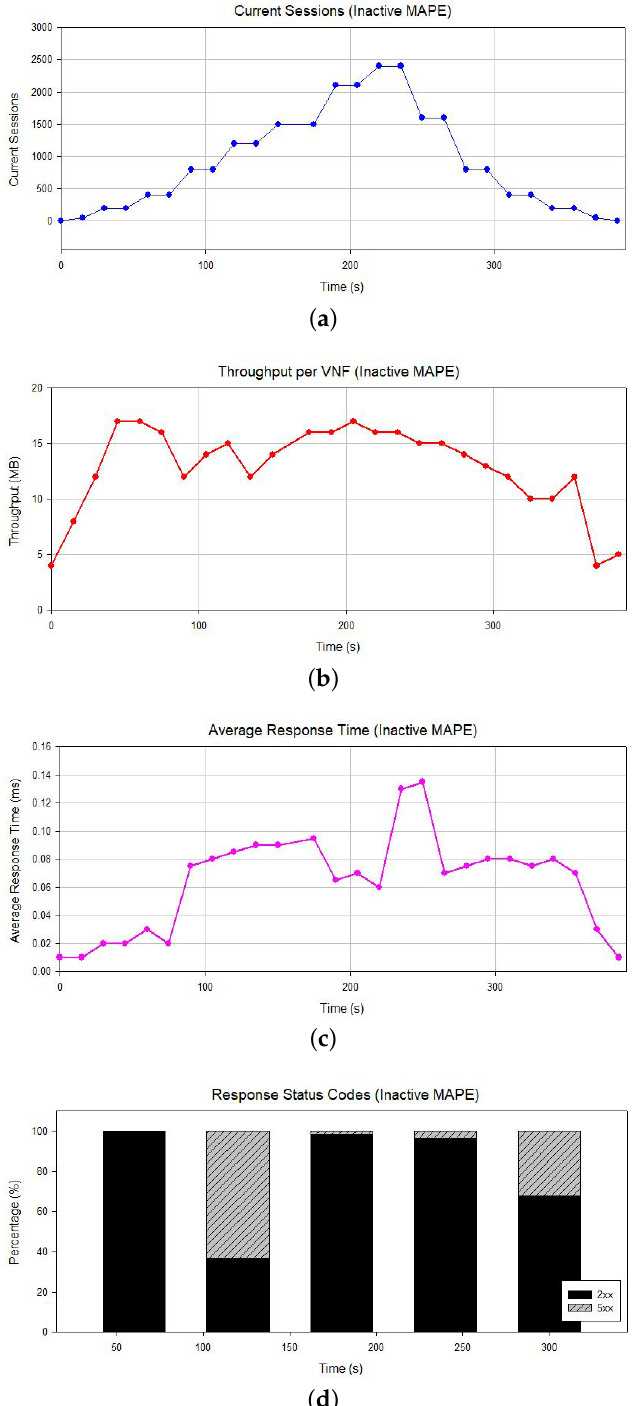
Figure 7. Statistics for inactive MAPE. ( a ) Active sessions; ( b ) throughput per VNF; ( c ) average response time; ( d ) HTTP response